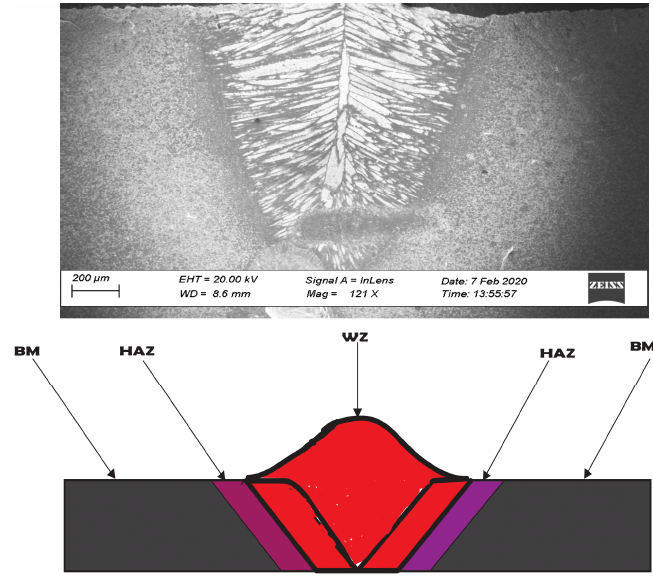
Figure 2. Schematic diagram showing laser welding process.